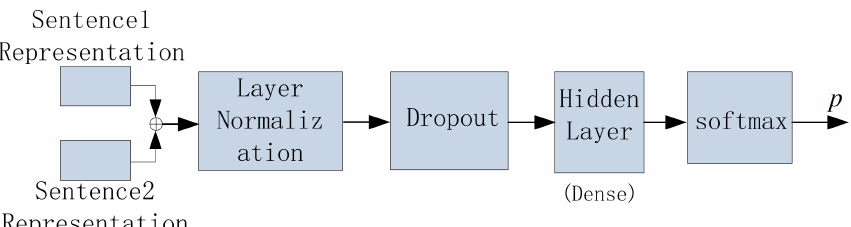
Figure 9. The architecture of the NLI classifier.